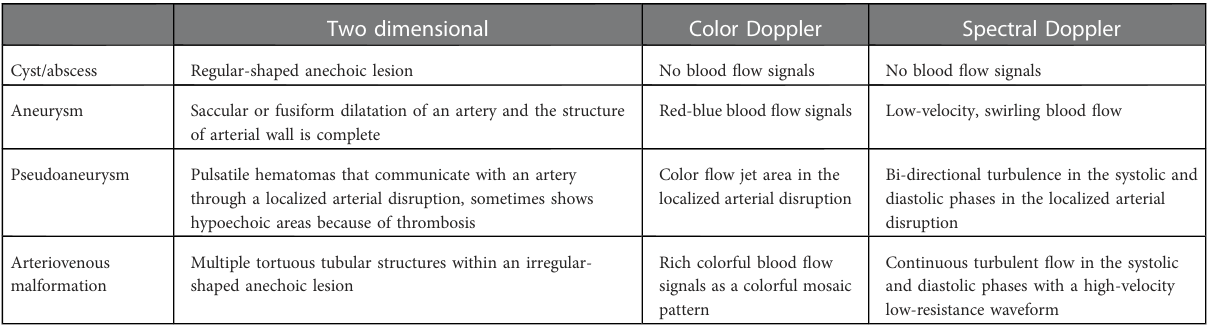
TABLE 2 Key points of differential diagnosis by US in pelvic cystic